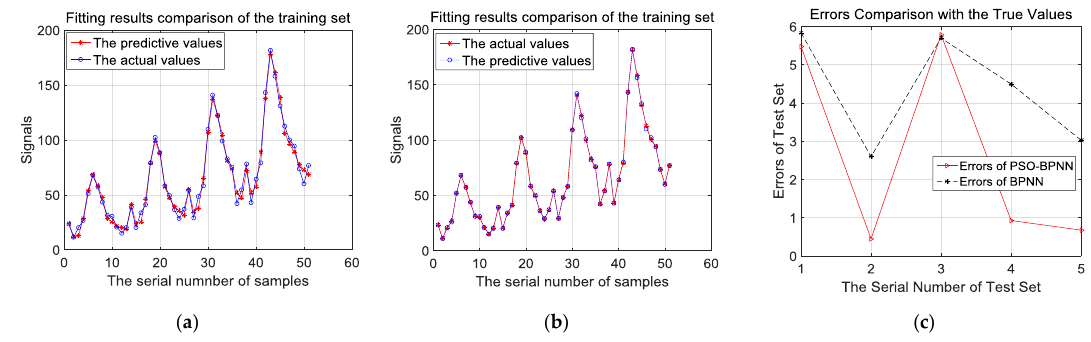
Figure 10. ( a ) Fitting results comparison of the training set by BPNN; ( b ) fitting results comparison of the training set by PSO-BPNN; ( c ) test set errors comparison of BPNN and PSO-BPNN.